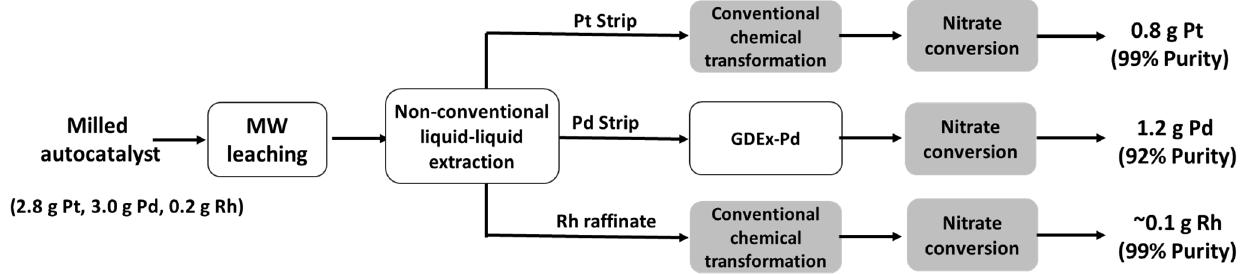
Figure 14. Overview of PLATIRUS approach used to produce the solutions of recycled PGMs in nitrate form (Reproduced with permission from [11]).